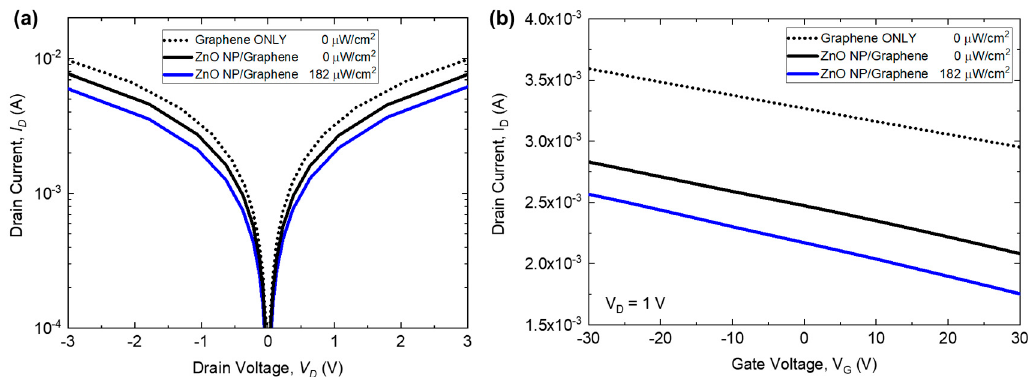
Figure 6. Electrical transport properties of both the ZnO / graphene phototransistors and the graphene-only phototransistors. Photocurrent as a function of ( a ) drain voltage and ( b ) the applied gate voltage at a drain voltage, V D of 1V.